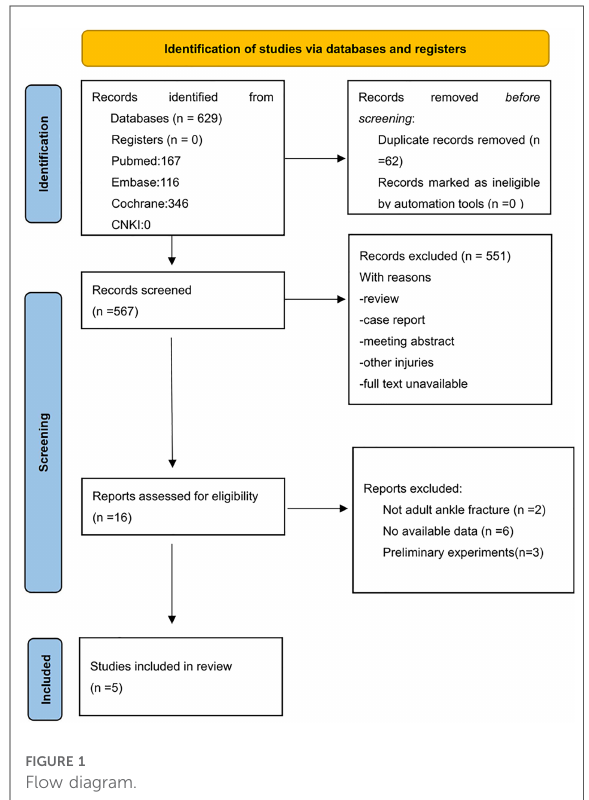
FIGURE 1 Flow diagram.